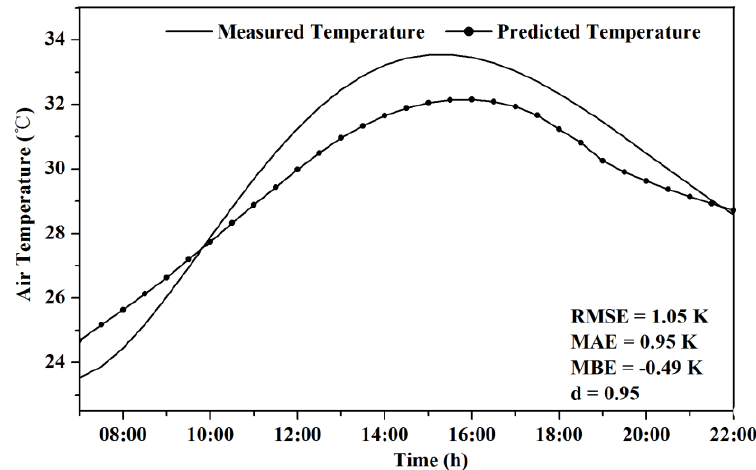
Figure 4. Comparison between hourly averaged air temperature from meteorological station and mean modeled temperature from ENVI-met simulations at 1.5 m above ground. RMSE = root mean squared error; MAE = mean absolute error; MBE = mean bias error; d = index of agreement.